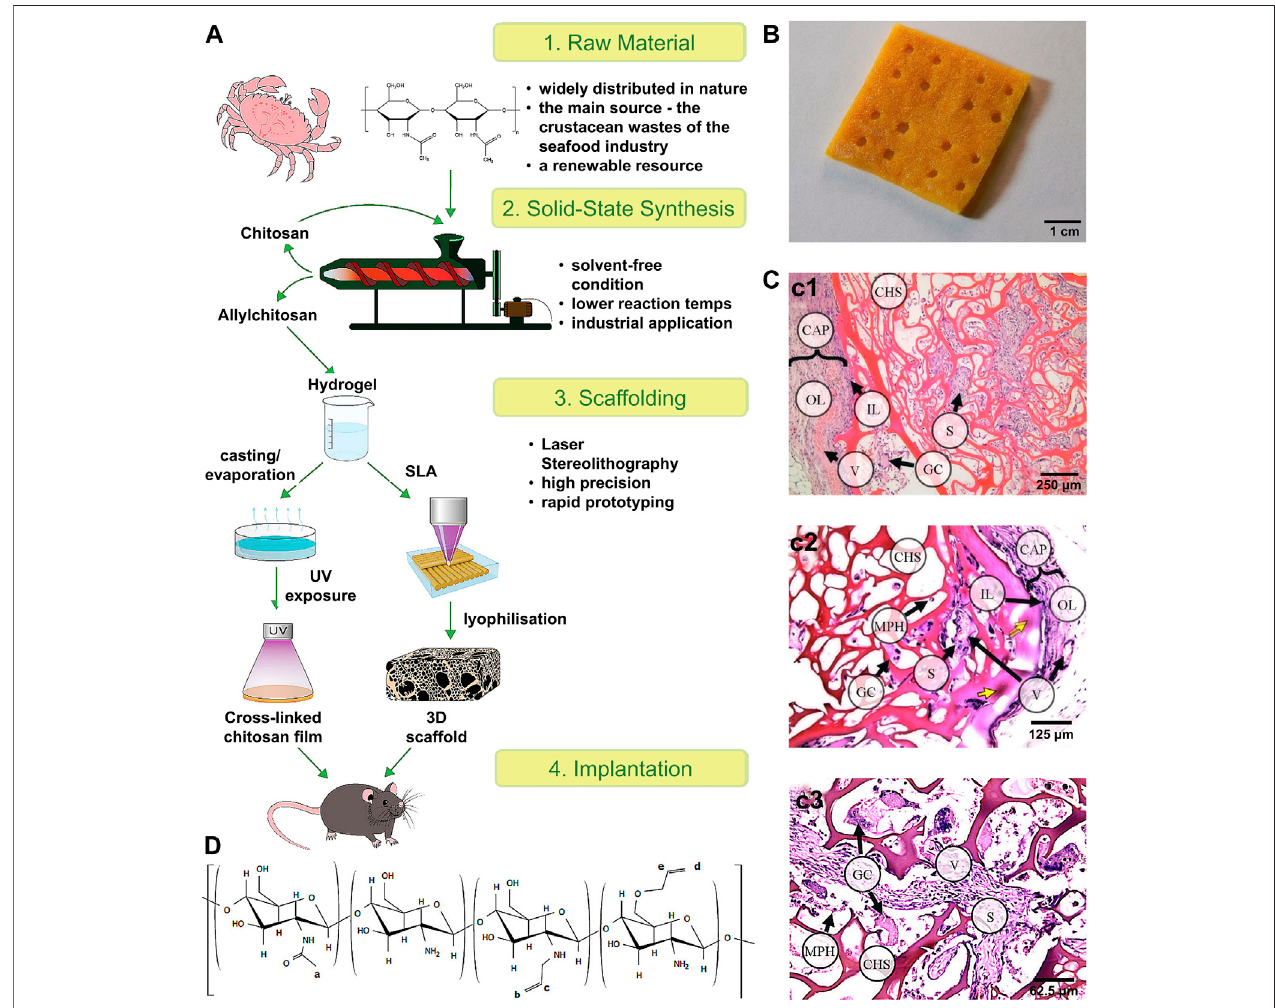
FIGURE5| Schemeoftheexperimentalworkandthetissuereactiontothe3Dscaffold. (A) Schemeoftheexperimentalwork. (B) 3Dporousallylchitosansscaffold (the chitosan sponges) after freeze drying. (C) Tissue reaction to the porous 3D scaffolds based on allylchitosans. c1) 30 days: the chitosan sponge (CHS) material was oxyphilic;c2) 60 days: a basophilic focus(yellow arrows) in thesurface septa of the CHS material;and c3) 90 days: deep CHS sections: most of thescaffold septa were moderately basophilic. (D) The structure of the synthesized allylchitosans. Reproduced with permission (Bardakova et al., 2019). Copyright 2021, Elsevier Ltd.